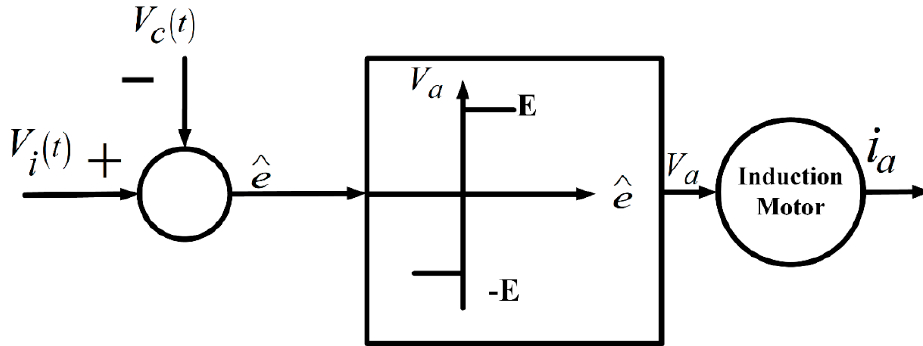
Figure 6. Block diagram for 3-phase idealized pulse width modulation (PWM) inverter.